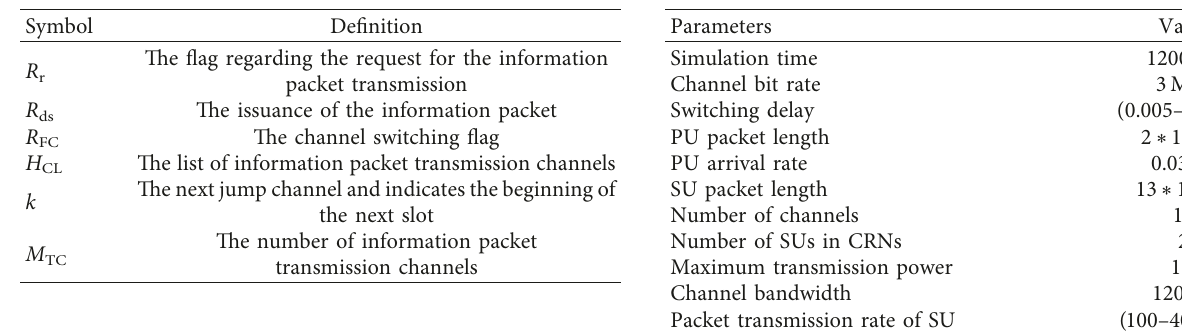
Table 4: Simulation parameters.